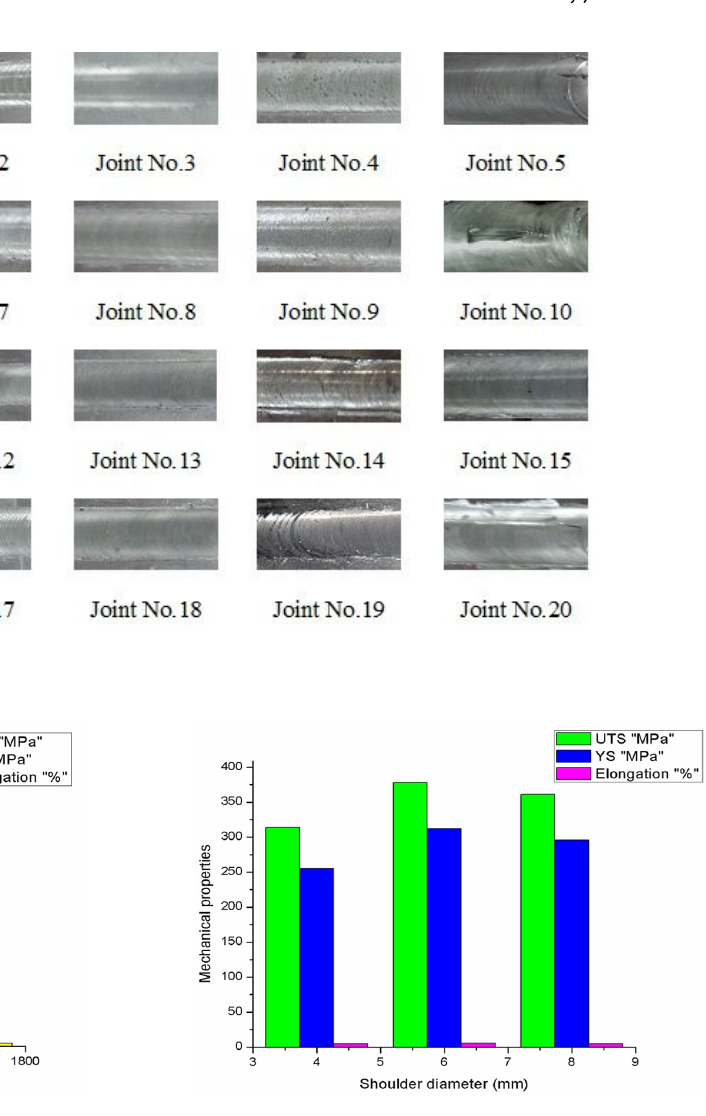
Figure 8: Effect of rotational speed on tensile strength